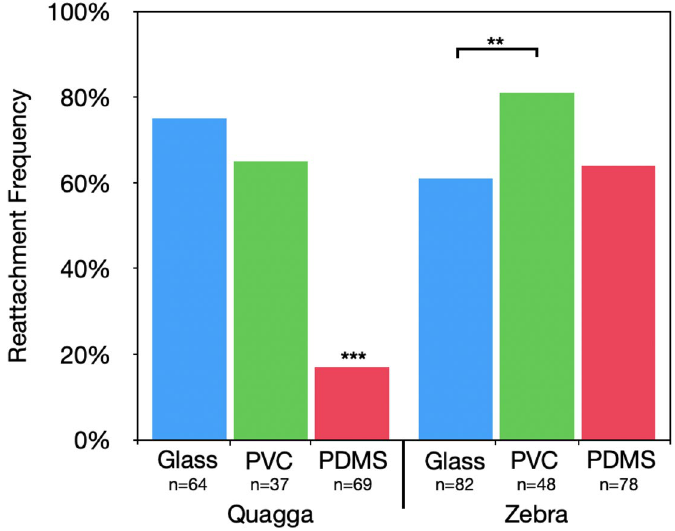
Figure 1. Quagga and zebra mussel attachment frequency on glass, PVC, and PDMS. n values correspond to the total number of mussels placed on a given substrate type. ** denotes p ≤ 0.01.